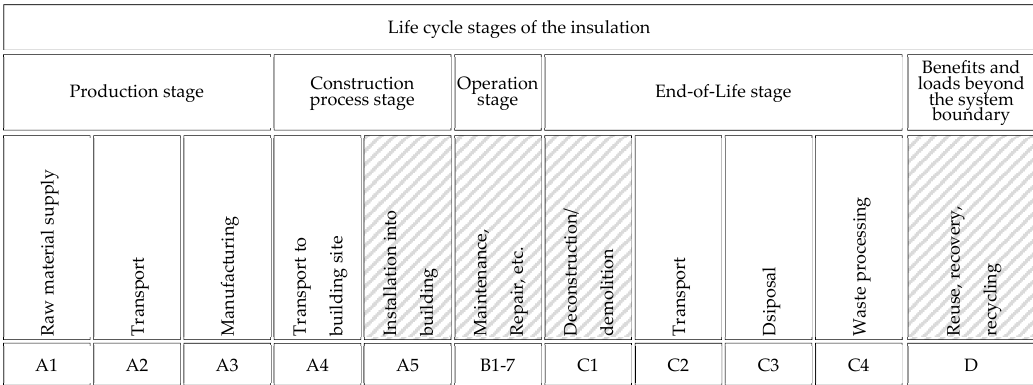
Figure 2. Life cycle stages of the insulation as described in EN 25978:2012 [14]. The hatched boxes are disregarded in the tool. The text in “Raw material supply” refers to Supplementary